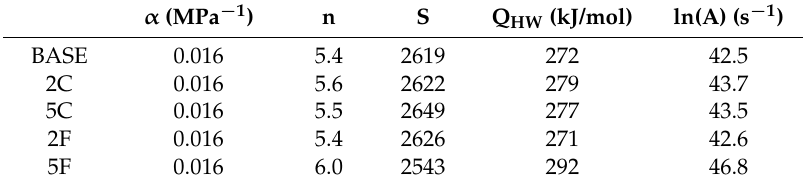
Table 5. Constituent values for the APM materials modeled in accordance with Equation